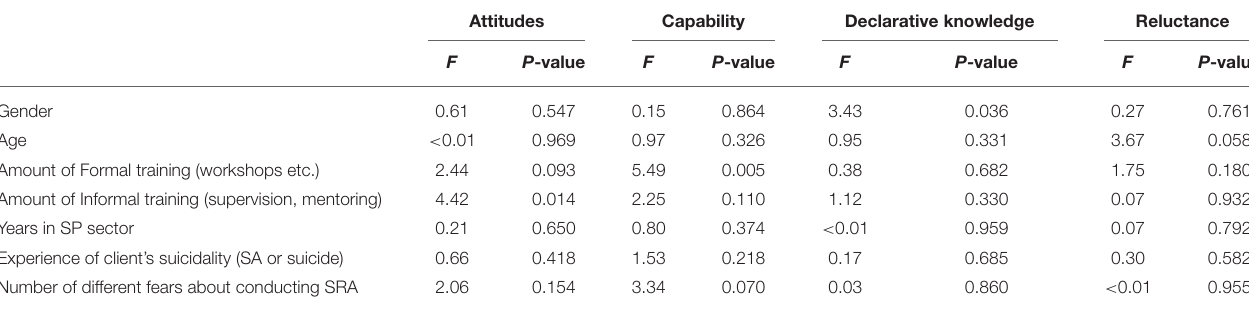
TABLE 6 | Fixed effect estimates predicting change (post-pre) of main outcome measures in linear mixed-effects